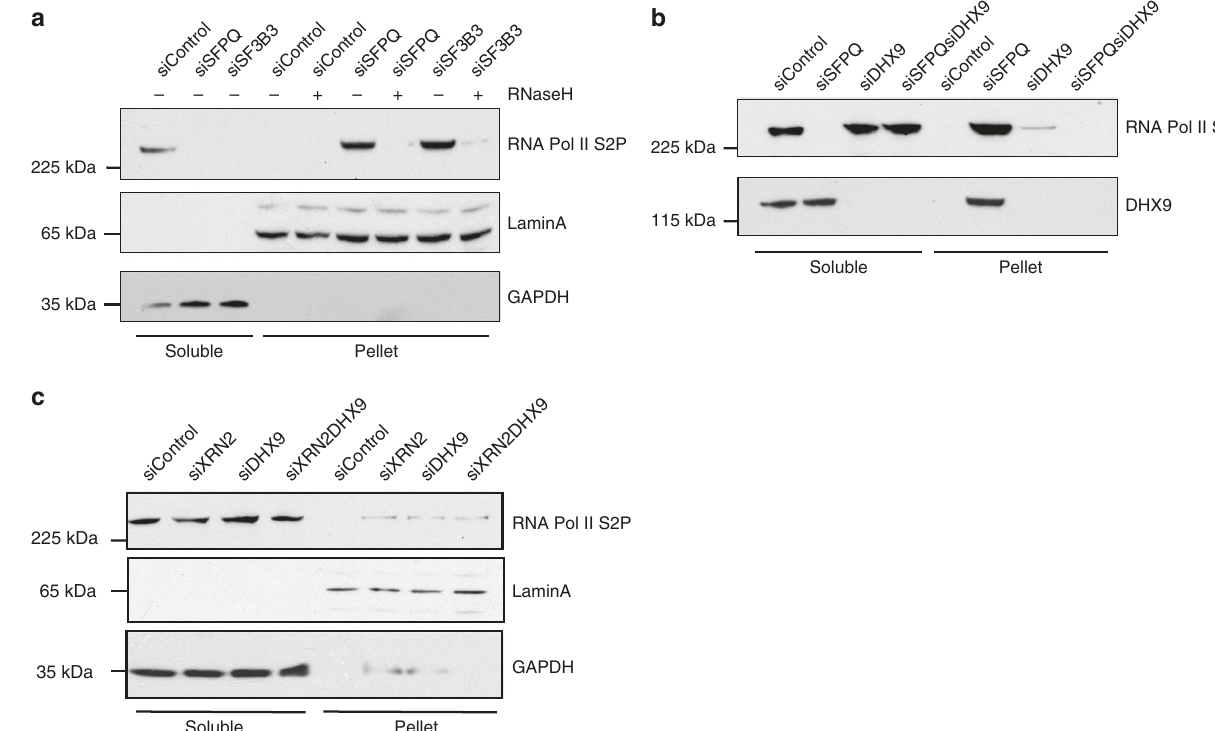
Fig. 9 DNA – RNA hybrid traps RNA Polymerase II on chromatin. a Depletion of SFPQ and SF3B3 causes retention of RNA Pol II on chromatin that is released by treatment with RNAseH1. Western blot of soluble (cytoplasmic) and insoluble (pellet) fractions of nuclear extracts prepared from HeLa cells that were knocked down with siRNAs against the indicated genes. Blots were also probed for GAPDH and LaminA to validate cytoplasmic and chromatin pellet fractions, respectively. b As in a showing that knockdown of DHX9 in cells depleted of SFPQ reverses the retention of RNA Pol II S2P on chromatin. c RNA Pol II (S2P) is not retained in the insoluble chromatin pellet from cells knocked down for